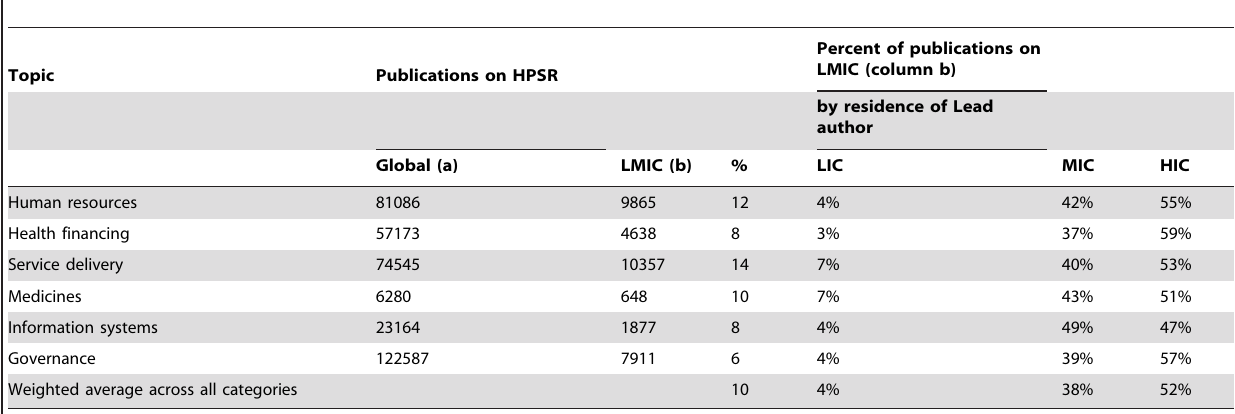
Table 2. Number and percent of HPSR publications focusing on Low-income and middle-income country by topic area